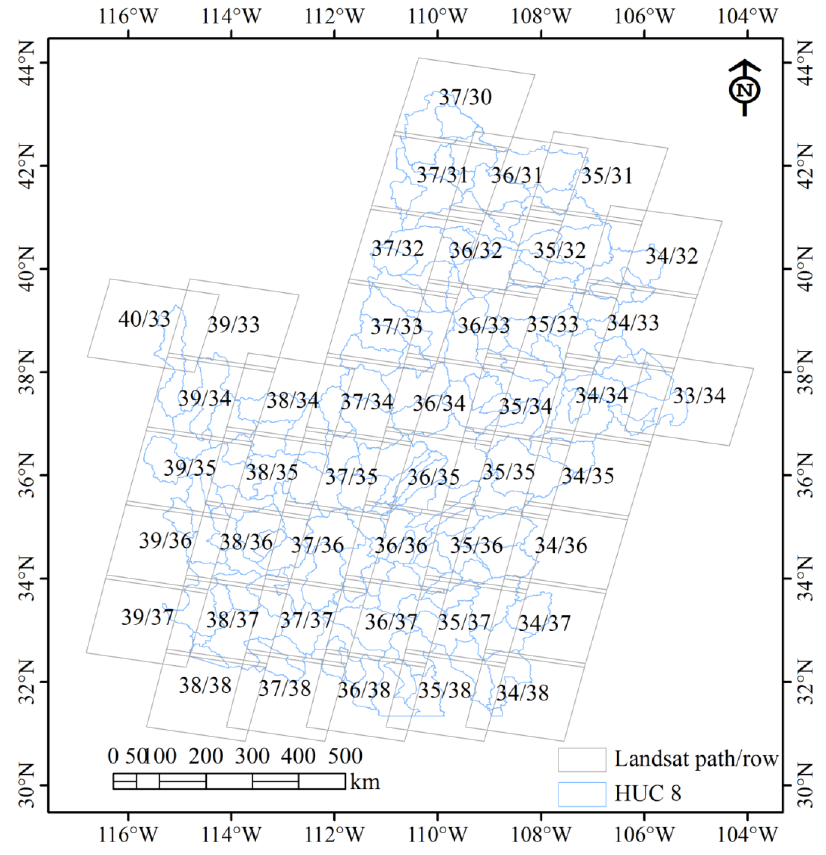
Figure 3. Coverage of Landsat TM/ETM+ images (path/row) in the Colorado River Basin based on the worldwide reference system